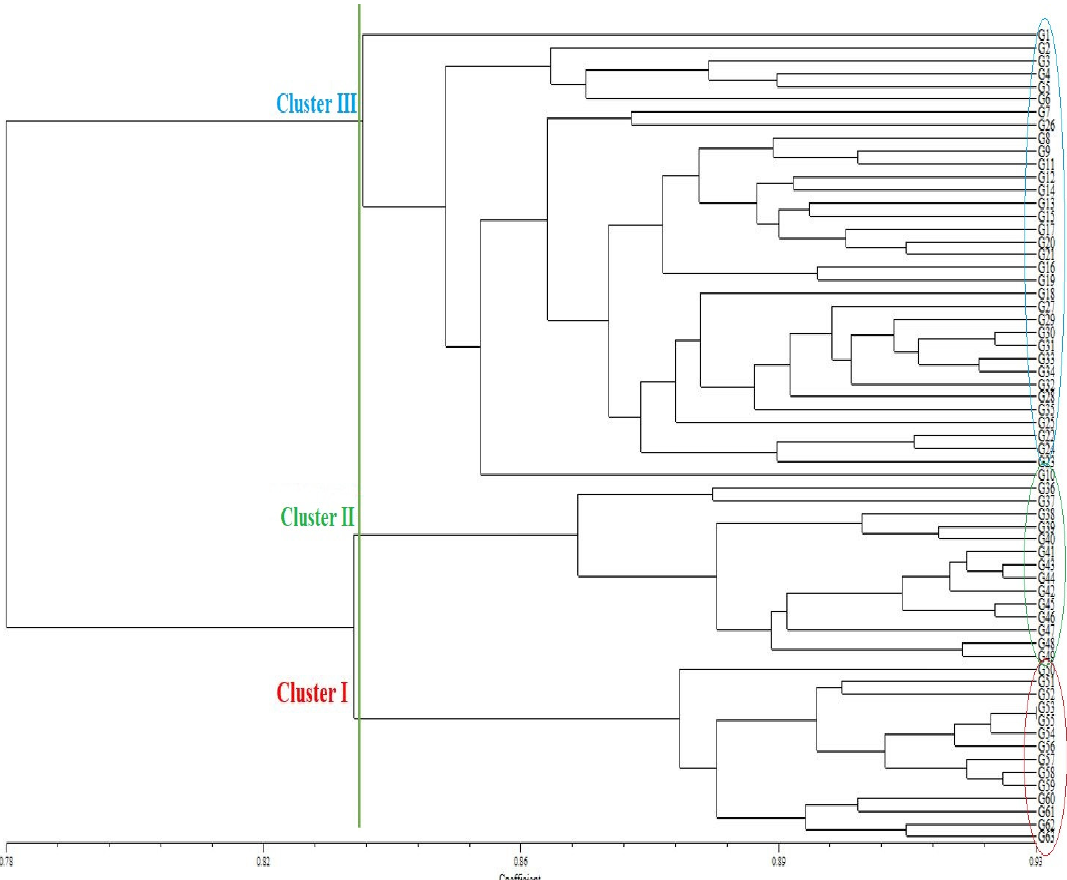
Figure 1. Dendrogram of 63 wheat genotypes generated with data from 34 inter-Primer Binding Site (iPBS) primers.